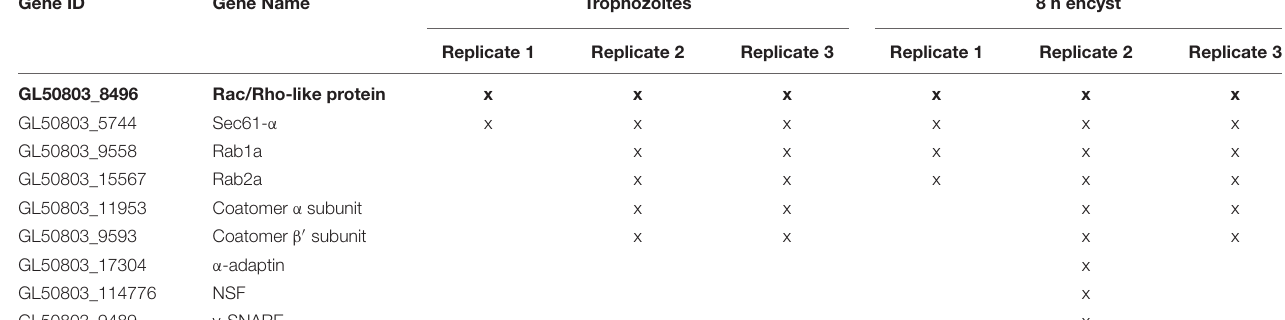
TABLE 1 | List of candidate genes selected for this study and identified as hits in OS- Gl Rac pulldown experiment in trophozoites and encysting cells (8 h p.i.e.) that are homologs of known membrane trafficking players.